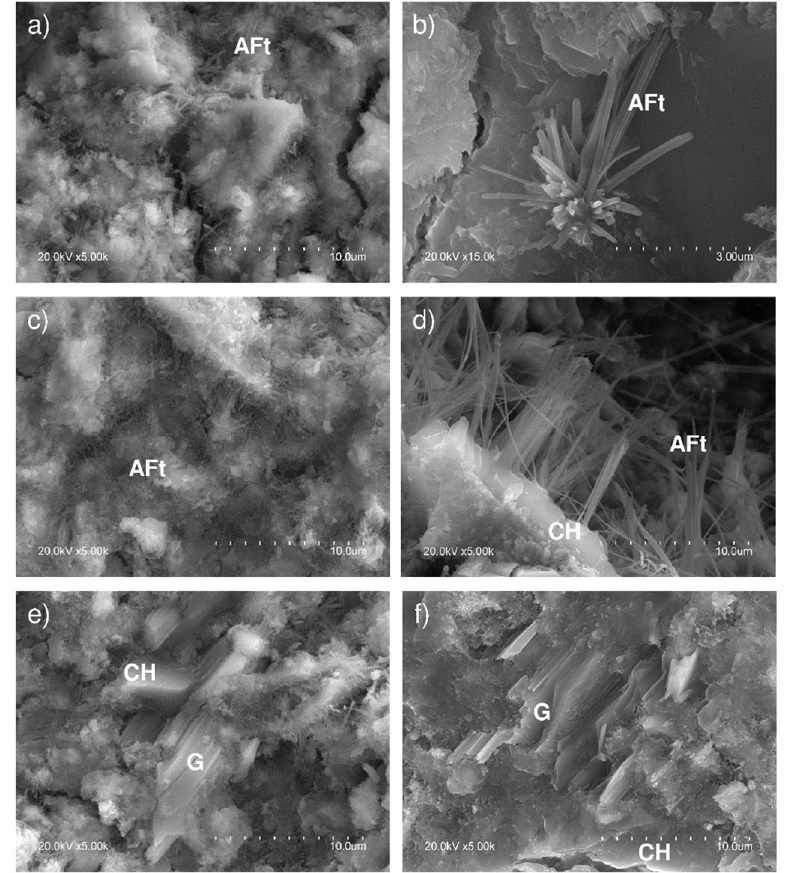
Figure 10. SEM micrographs of cement pastes soaked for 180 days in Na 2 SO 4 : ( a , c ) pores filled with ettringite (AFt) needles; ( b , d ) detail of AFt needles growing inside pores at the expense of portlandite plate (CH) dissolution; and, ( e , f ) gypsum (G) precipitation on portlandite plates.